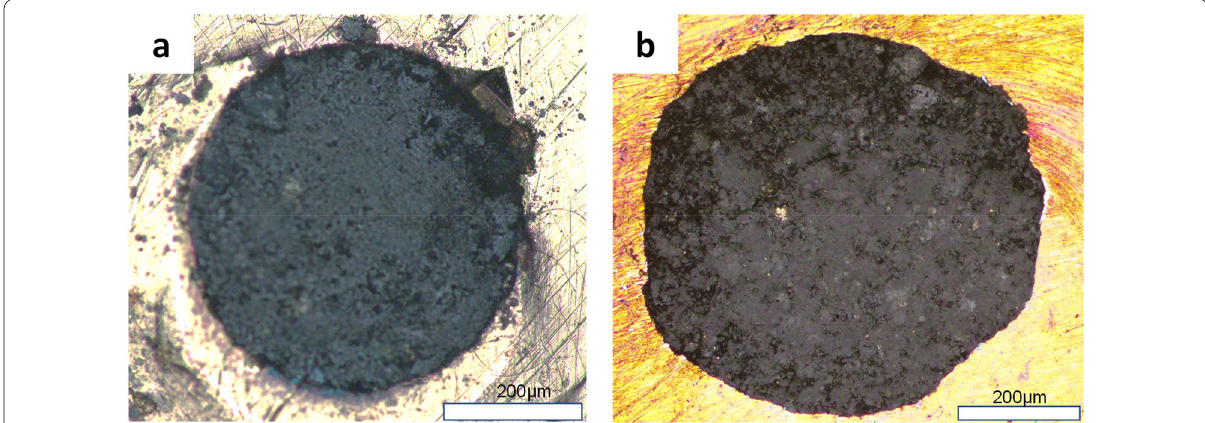
Fig. 6 Optical images of the pelletized Murchison samples. a . A Murchison pellet made of ~ 0.1 mg Murchison powder. b . A Murchison pellet made of ~ 0.3 mg Murchison powder